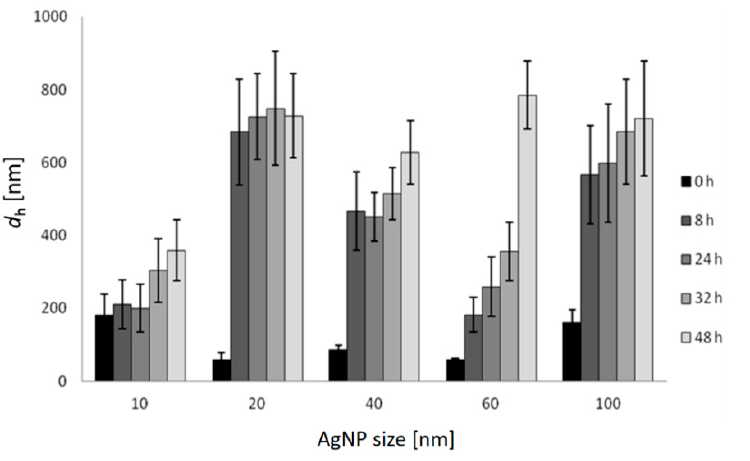
Figure 2. Hydrodynamic diameters ( d h ) and standard deviations of differently sized AgNPs in FSW over 48 h ( c = 1 mg L − 1 ) based on volume size distribution.